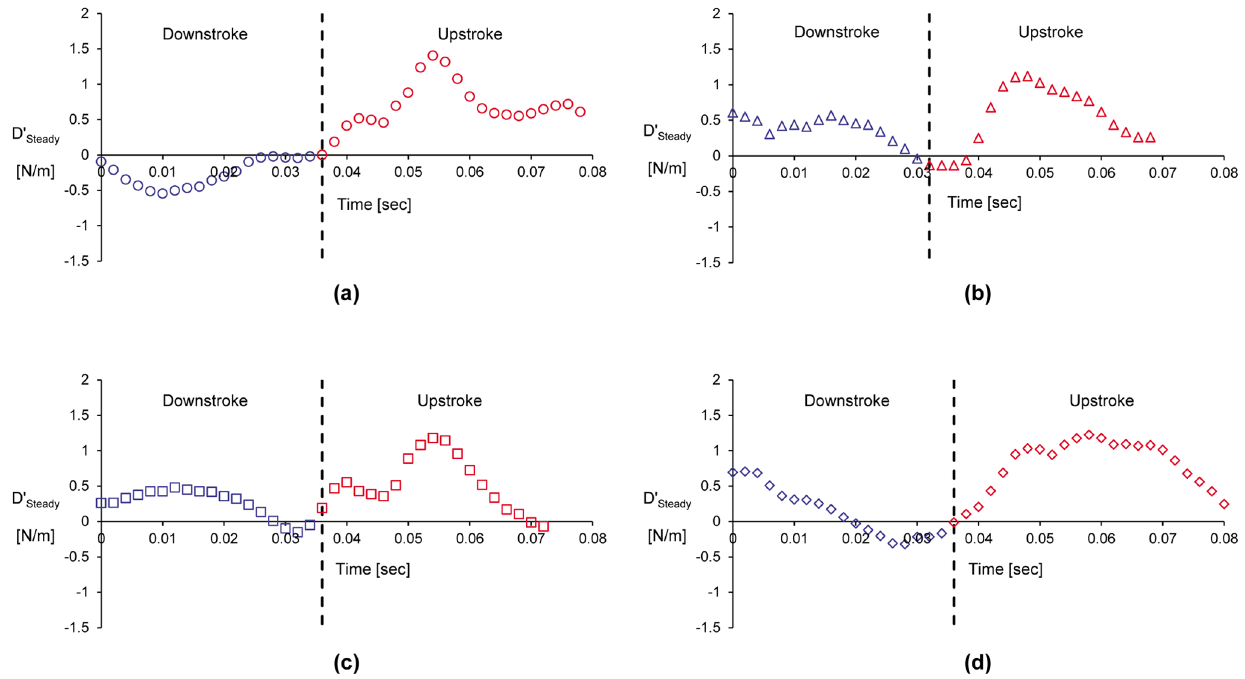
Figure 11. Steady drag per unit span versus time, as computed according to Eq. (10), for wingbeats no. 1 (a), 2 (b), 3 (c) and 4 (d). doi:10.1371/journal.pone.0080086.g011 Figure 12) uses a portion of the volume as an approximation to the total volume integral of h u/ h t. The unsteady drag results presented in Figure 13 demonstrate that h u/ h t is smaller than zero as expected during the downstroke as the bird generates lift and propels itself forward [51]. At the beginning of the upstroke, the